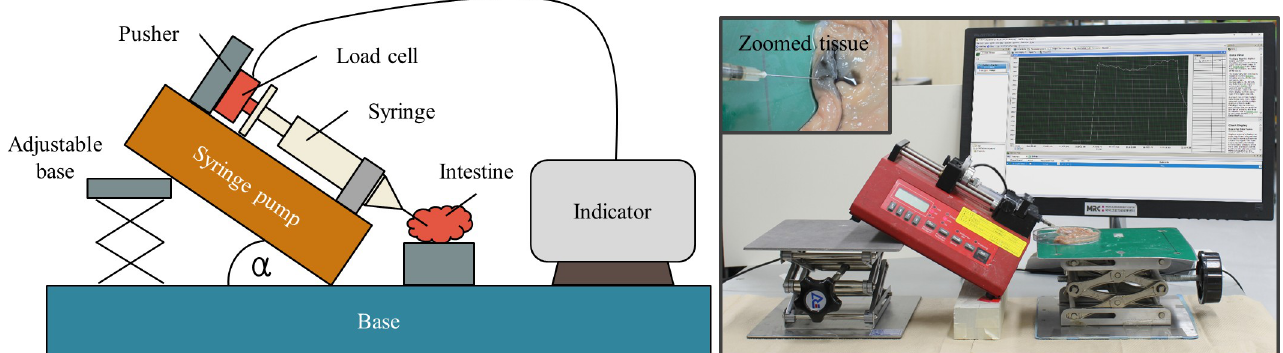
Fig 9. Experiment to evaluate the submucosal injection force. The left figure is the schematic diagram of the experiment setup and the right figure shows the actual photoshoot.